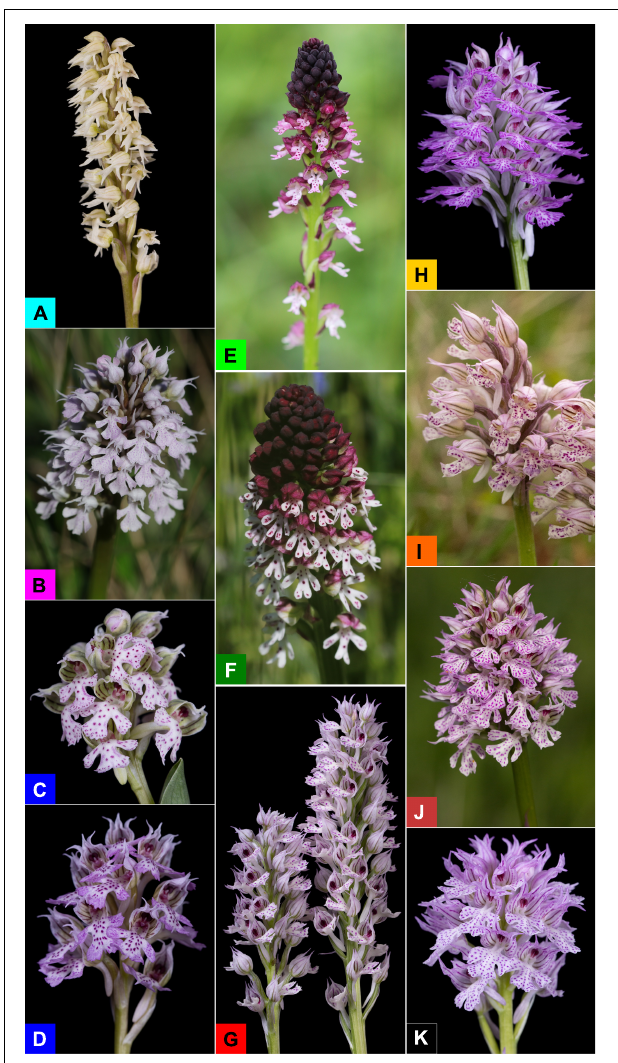
FIGURE 2 | Inflorescences of ten molecularly circumscribed lineages/taxa of Neotinea discussed in the present phylogenetic study: Neotinea maculata (Cyprus, A ), N. conica (Portugal, B ), N. lactea (Italy, Sardinia, C ), N. lactea putative hybrid (Greece, Crete, D ), N. ustulata subsp. aestivalis (Czechia, E ), N. ustulata subsp. ustulata (Czechia, F ), N. tridentata (Romania, G ), N. tridentata (Israel, H ), N. tridentata (Greece, Crete, I ), N. tridentata (Czechia, J ), N. commutata (Italy, Sicily, K ). The background color of the letters indicates the color used for the individual lineages in all figures throughout the